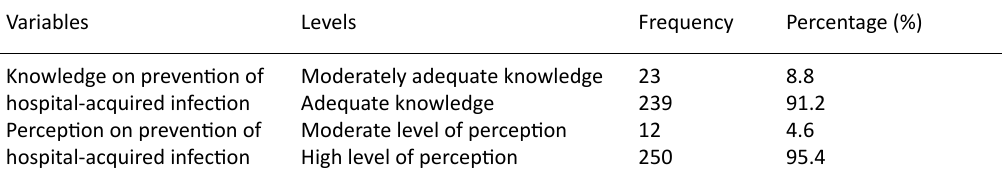
Table 5. Mean (SD) of the knowledge & perception of health care professionals (n = 262) Variables